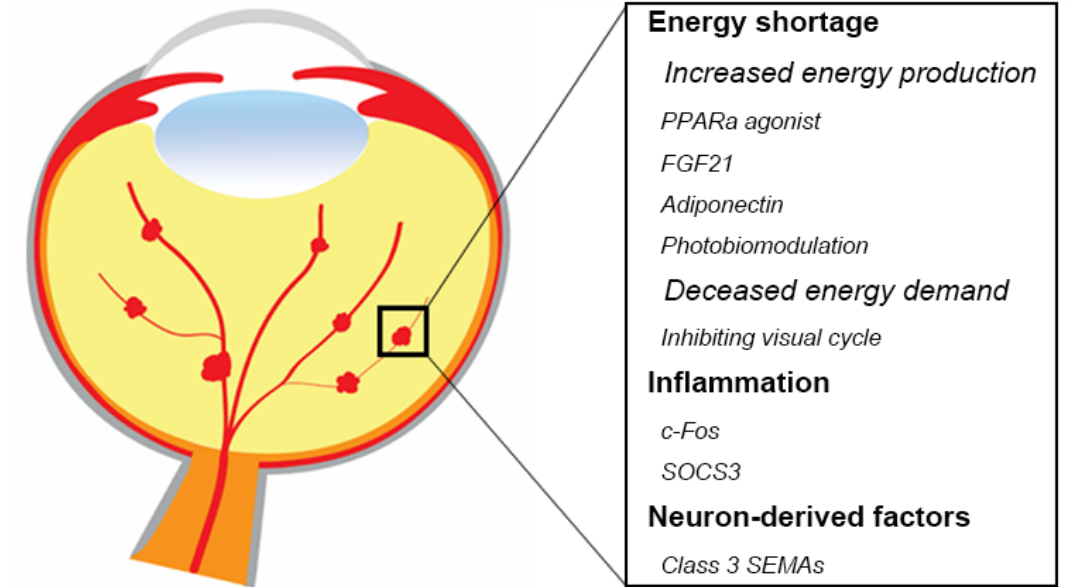
Figure 2. Summary of potential therapeutic targets in retinal neurovascular disorders. Modulating energy shortage, inflammation, as well as neuron-derived factors would be beneficial to protect against retinal neurons and inhibits pathological angiogenesis. Schematics were drawn by Dr. Shuo Huang, Ophthalmology, BCH.